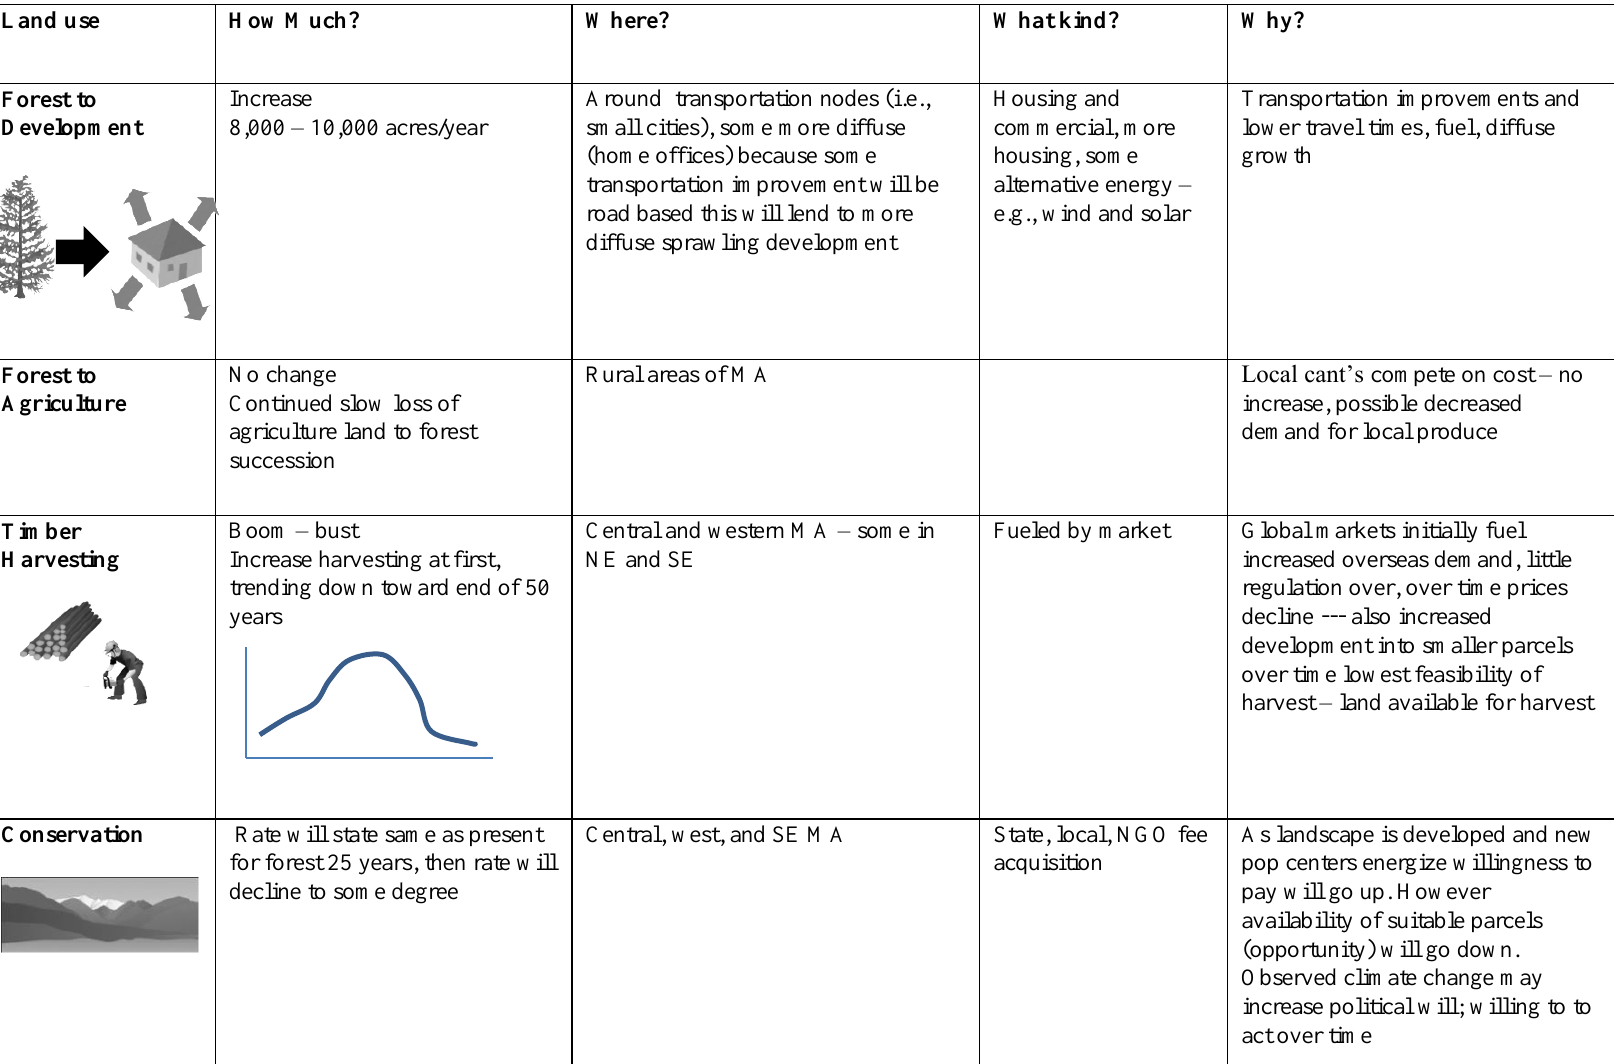
Table A2.5. Scenario 1: Living the Dream Land